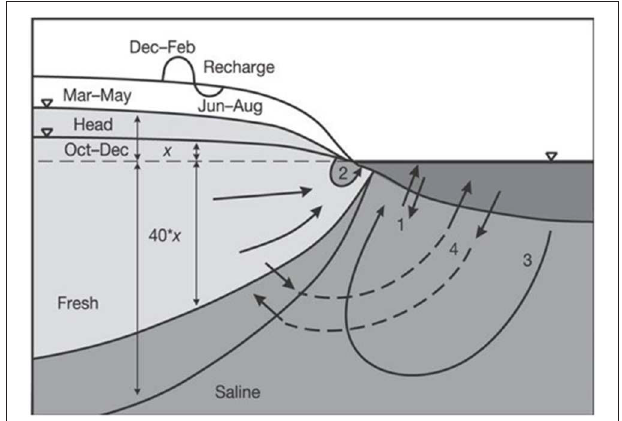
FIGURE 2 | Flow paths and some of the driving forces of SGD. Mechanisms shown include: (1) tidal pumping, (2) nearshore circulation due to tides and waves, (3) saline circulation driven by dispersive entrainment and brackish discharge, and (4) seasonal exchange ( Michael et al., 2005).